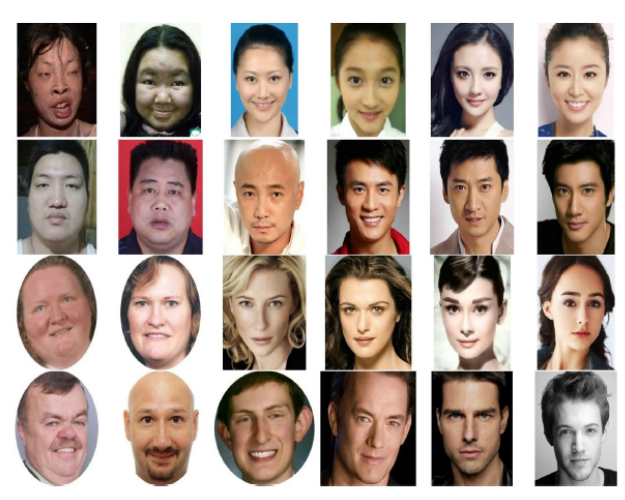
Figure 3. Some face images from the SCUT-FBP5500 dataset.